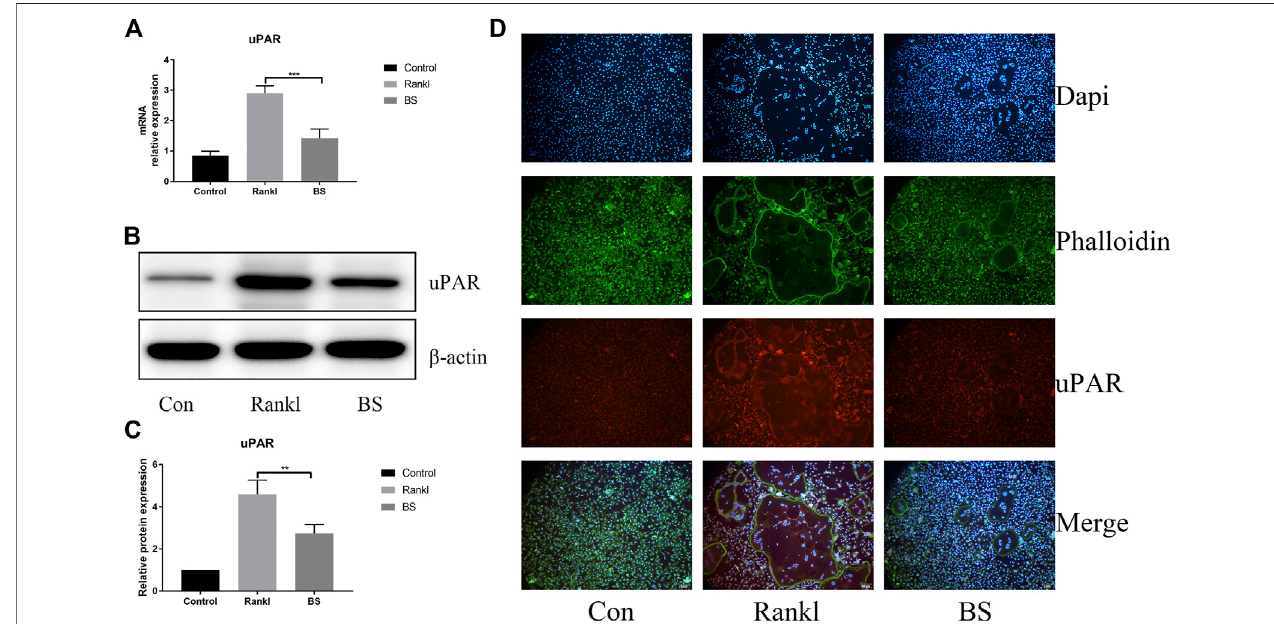
FIGURE 7 | BS attenuated RANKL-induced uPAR expression in BMMs. (A) uPAR mRNA level. (B) Representative western blot of uPAR treated with BS (C) Quantitative analysis of uPAR. (D) Immuno fl uorescence images for effects of BS on the protein expression of uPAR. All bar graphs are presented as mean ± SD; n = 3. pp p < 0.01; ppp p <